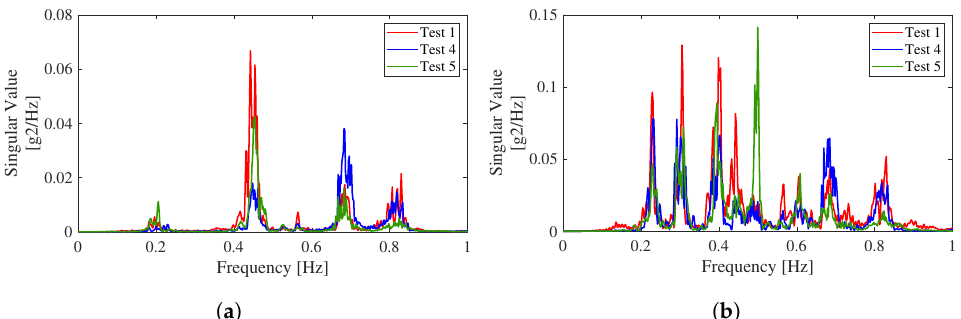
Figure 13. Singular values obtained from three tests: ( a ) transverse direction and ( b ) vertical direction.